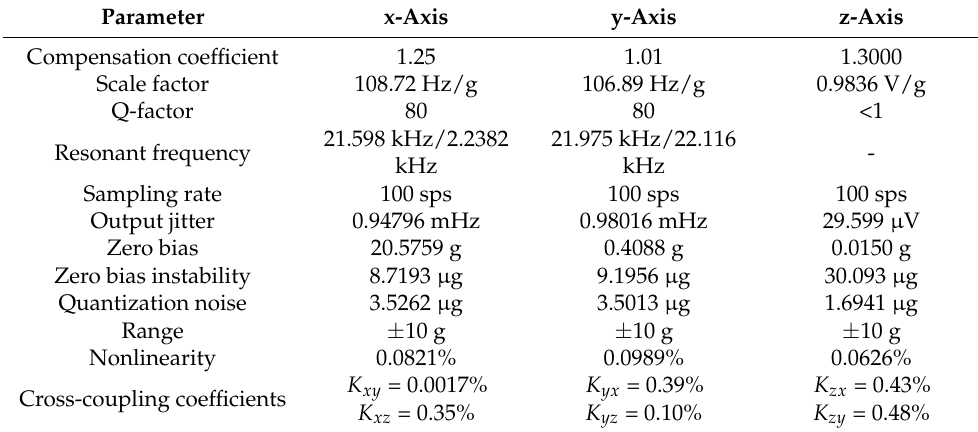
Figure 22. The output of the tri-axis accelerometer within 1 h at 100 sps. ( a ) Time domain plot of zero output; ( b ) Allan variance. Table 7. The experiment results of the tri-axis